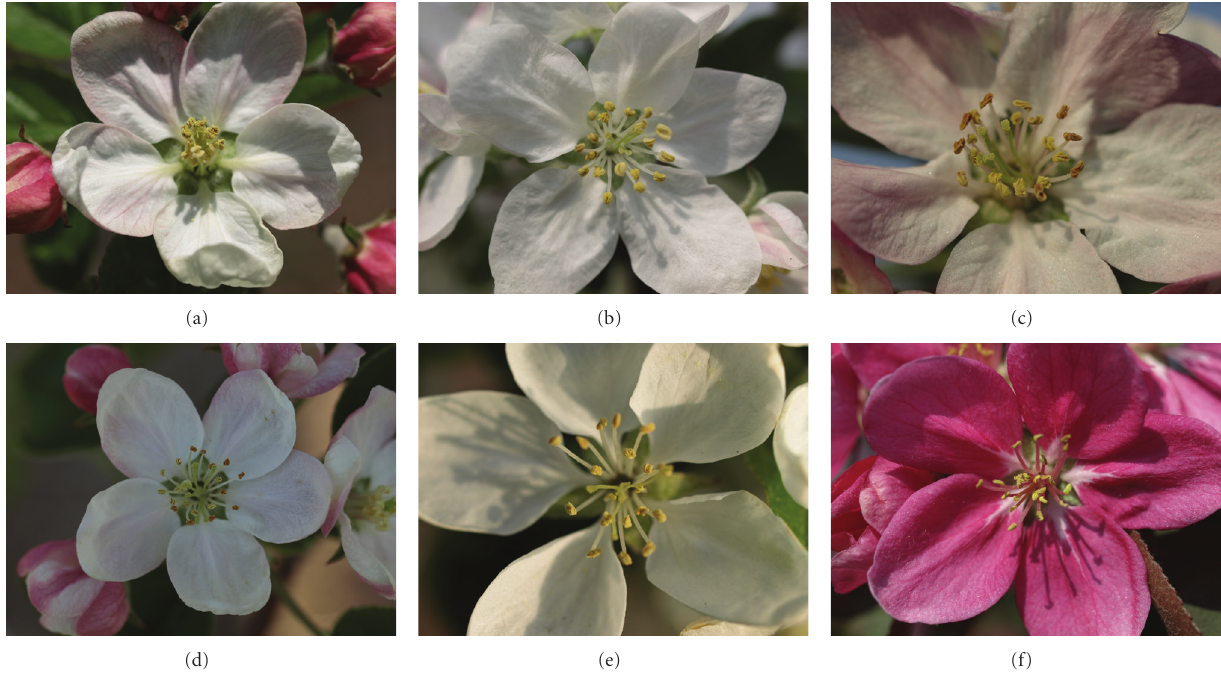
Figure 2: Stamens and a pistil morphology of apple flowers. (a) “Starking Delicious”, (b) “Fuji”, (c) “Shinano Gold”, (d) “Tsugaru”, (e) “Dolgo”, and (f)